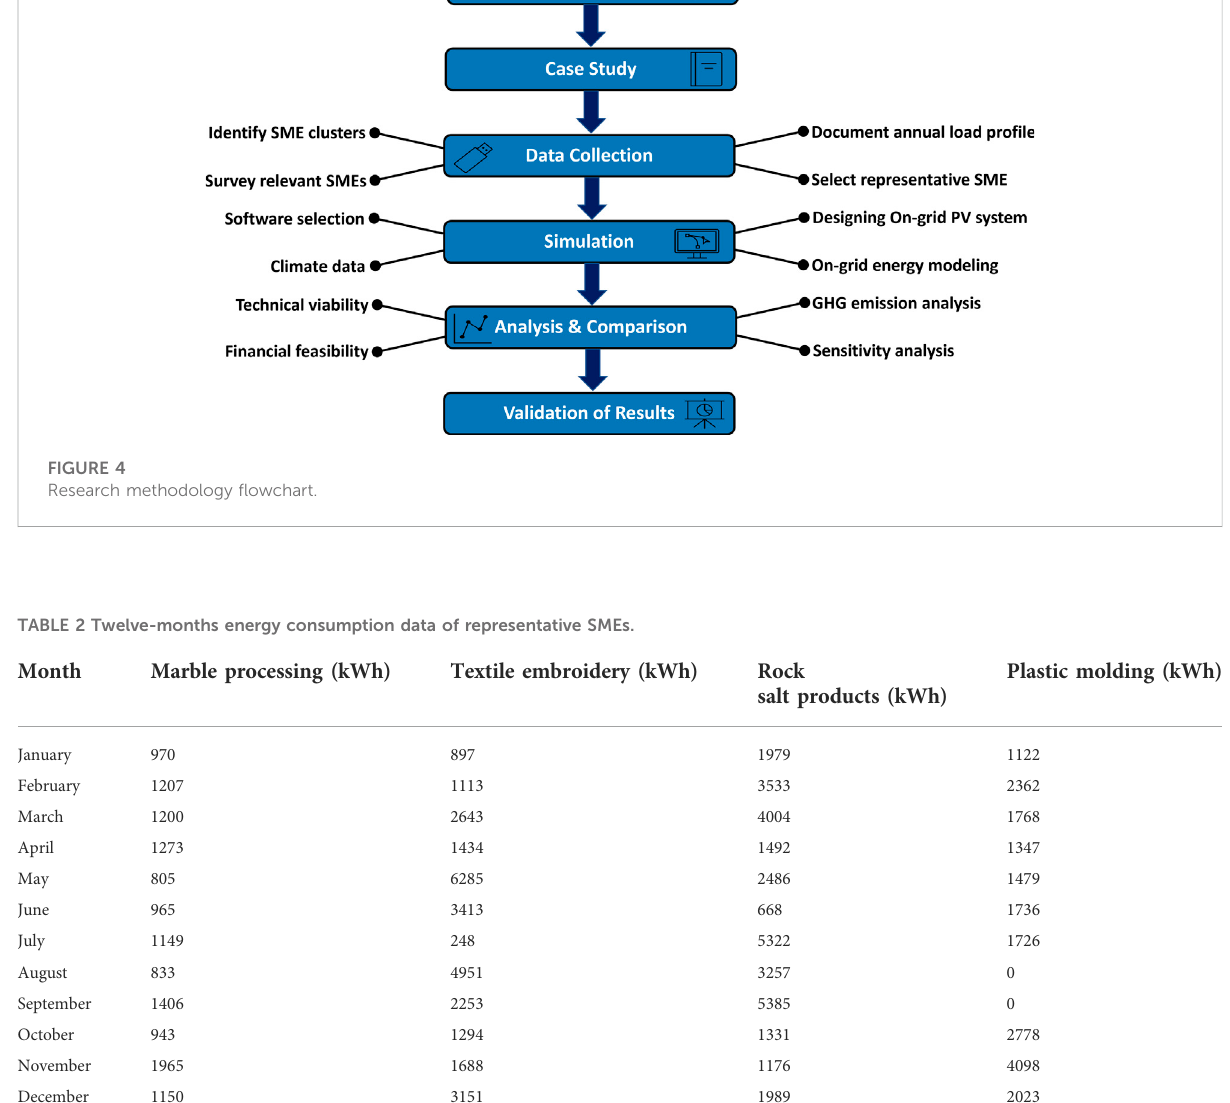
Plastic molding salt products (kWh)